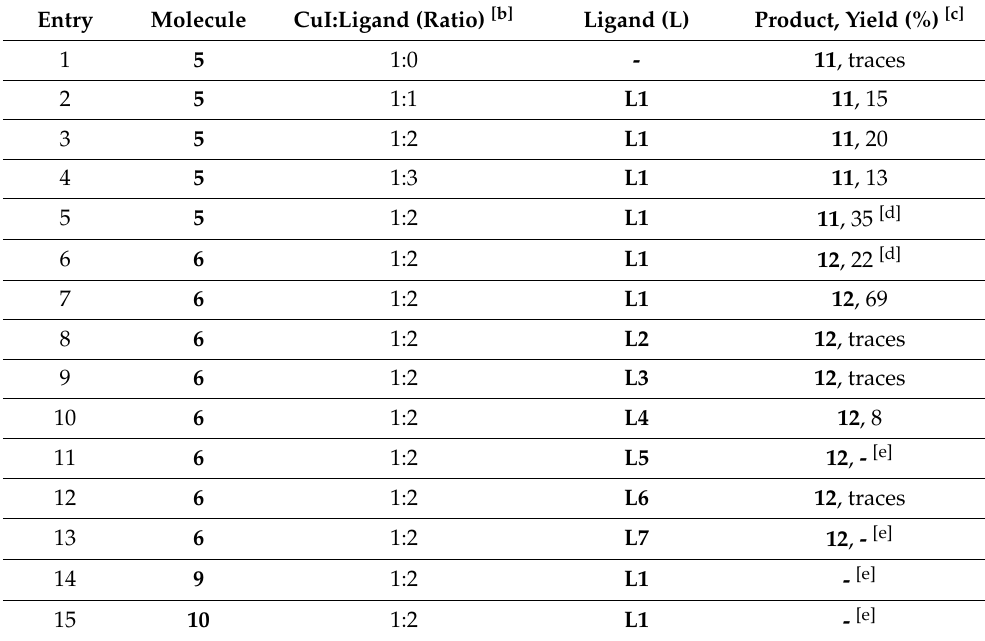
Table 1. Comparative studies utilizing various ligands and ratios of catalyst and ligand [a] .